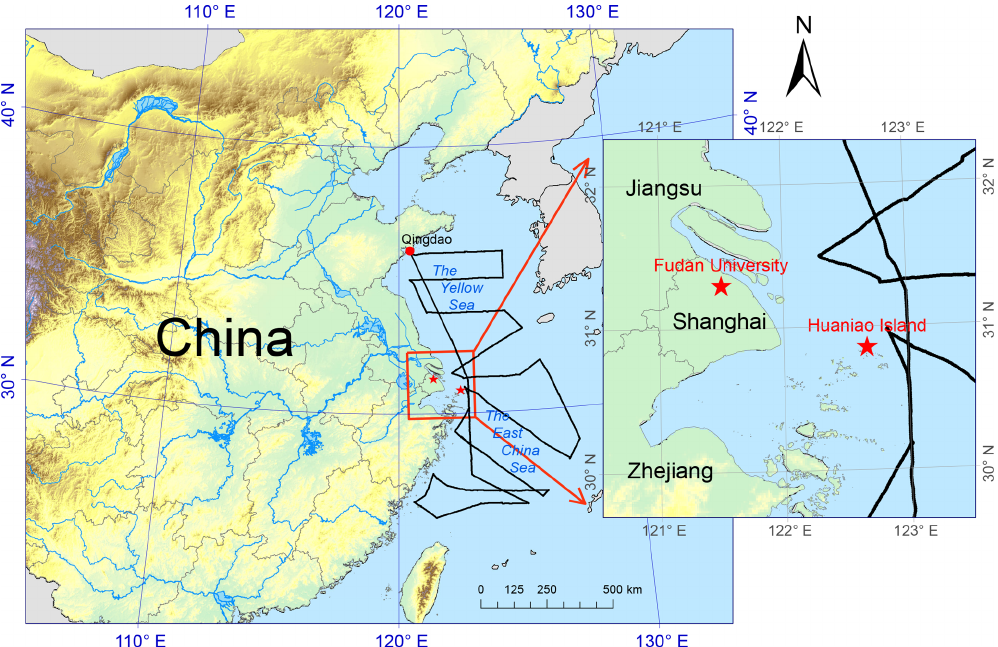
Figure 1. Map of sampling sites and area. The red stars represent the locations of Shanghai (Fudan University) and Huaniao Island, and the black line in the surrounding marginal seas represents the cruise track in the spring of